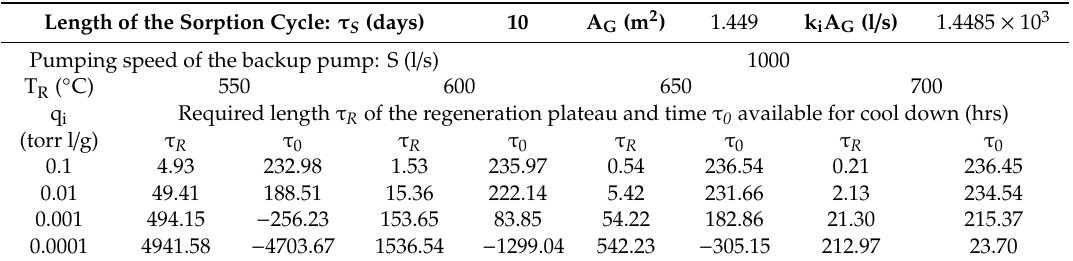
Table 9. Regeneration and cool-down times of ZAO for S = 1000 l / s and τ S = 10